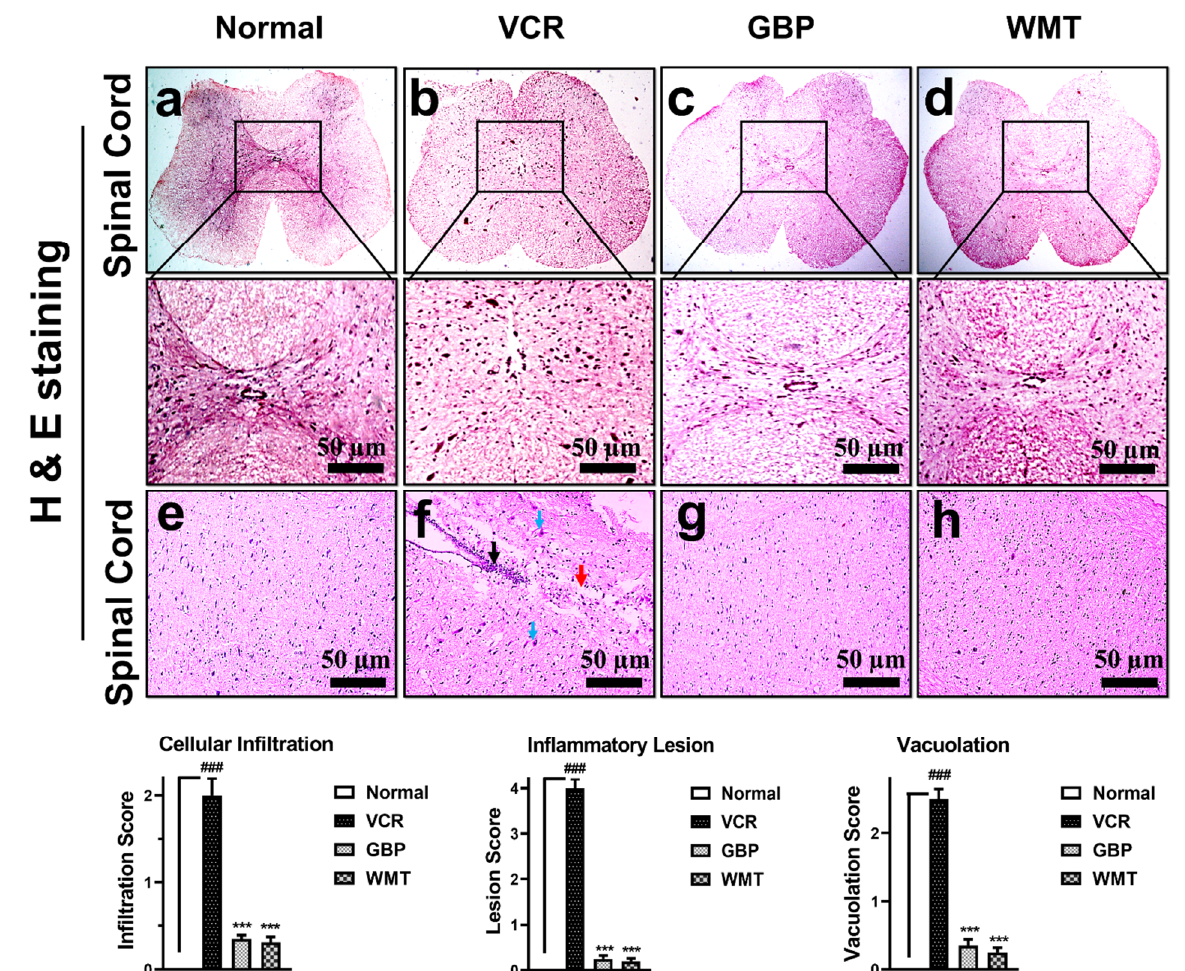
Figure 7. Effect of withametelin on the histopathological changes in the spinal cord. Representative photomicrographs of the transverse section of the spinal cord (H&E; 4 × and 10 × ). Normal ( a ), VCR ( b ), GBP ( c ), and WMT ( d ). WMT and GBP suppressed the VCR-induced histopathological changes, including cellular infiltration/inflammatory lesion and vacuolation in the spinal cord. Representative photomicrographs of the longitudinal section spinal cord (H&E; 10 × ). Normal ( e ), VCR ( f ), GBP ( g ), and WMT ( h ). WMT and GBP ameliorated histopathological alterations in the spinal cord. The black arrowhead shows inflammatory lesions, the red arrowhead shows vacuolation, and the sky-blue arrowhead shows vacuolar changes in the neurons. All results were expressed as the mean ( n = 3) ± SD. ### p < 0.001 compared to the normal control group; *** p < 0.001 compared to the VCR